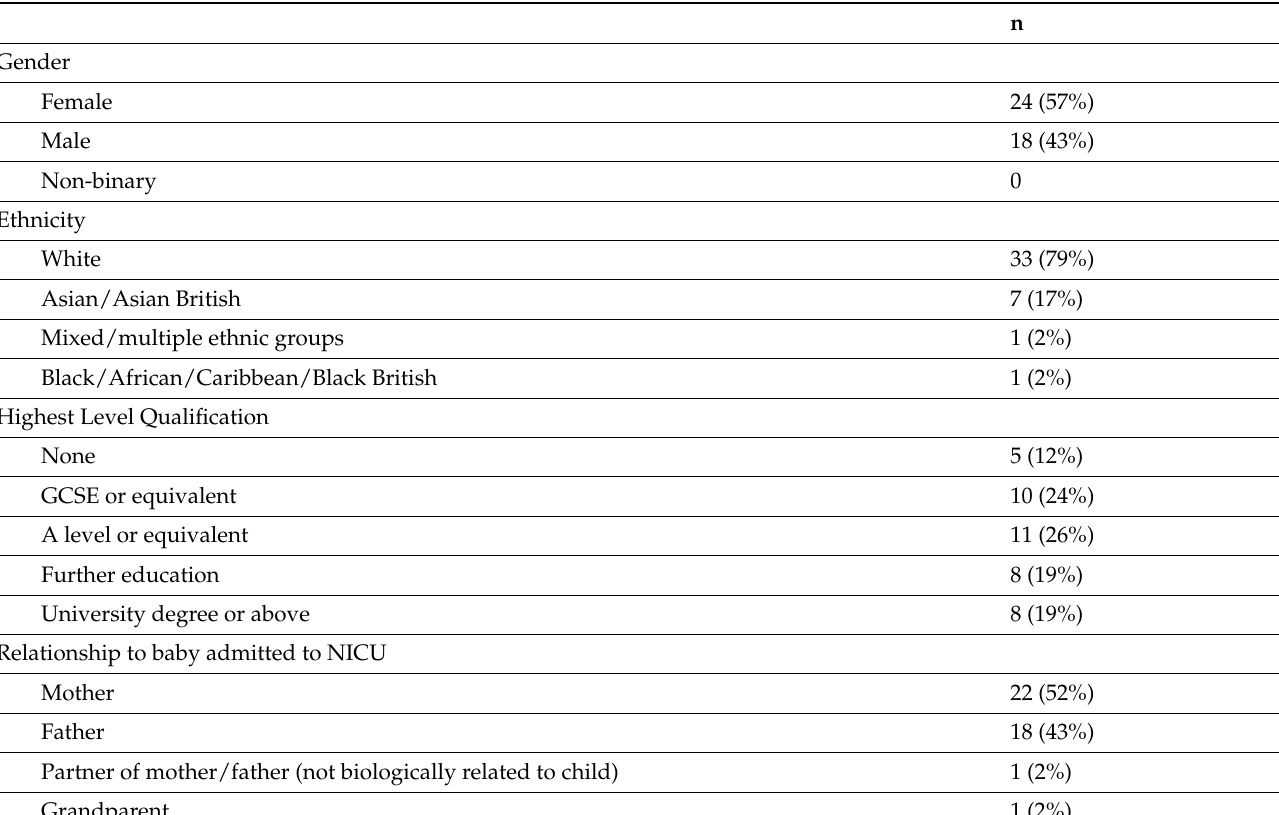
Table 1. Demographics of the interview